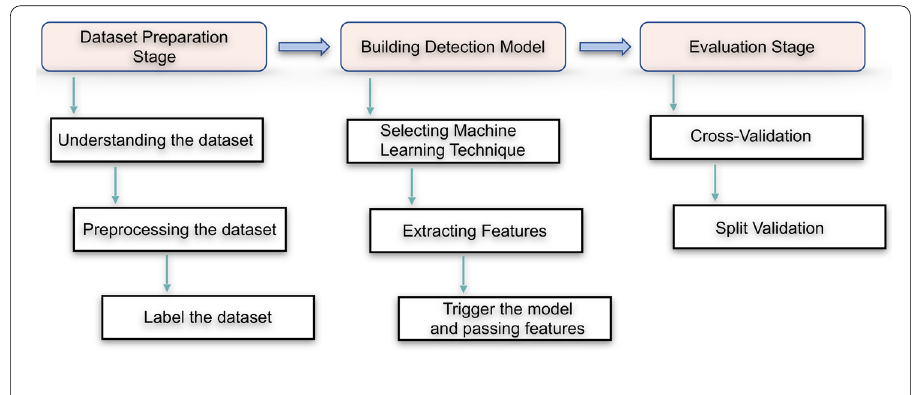
Fig. 4 Flowchart showing method in the